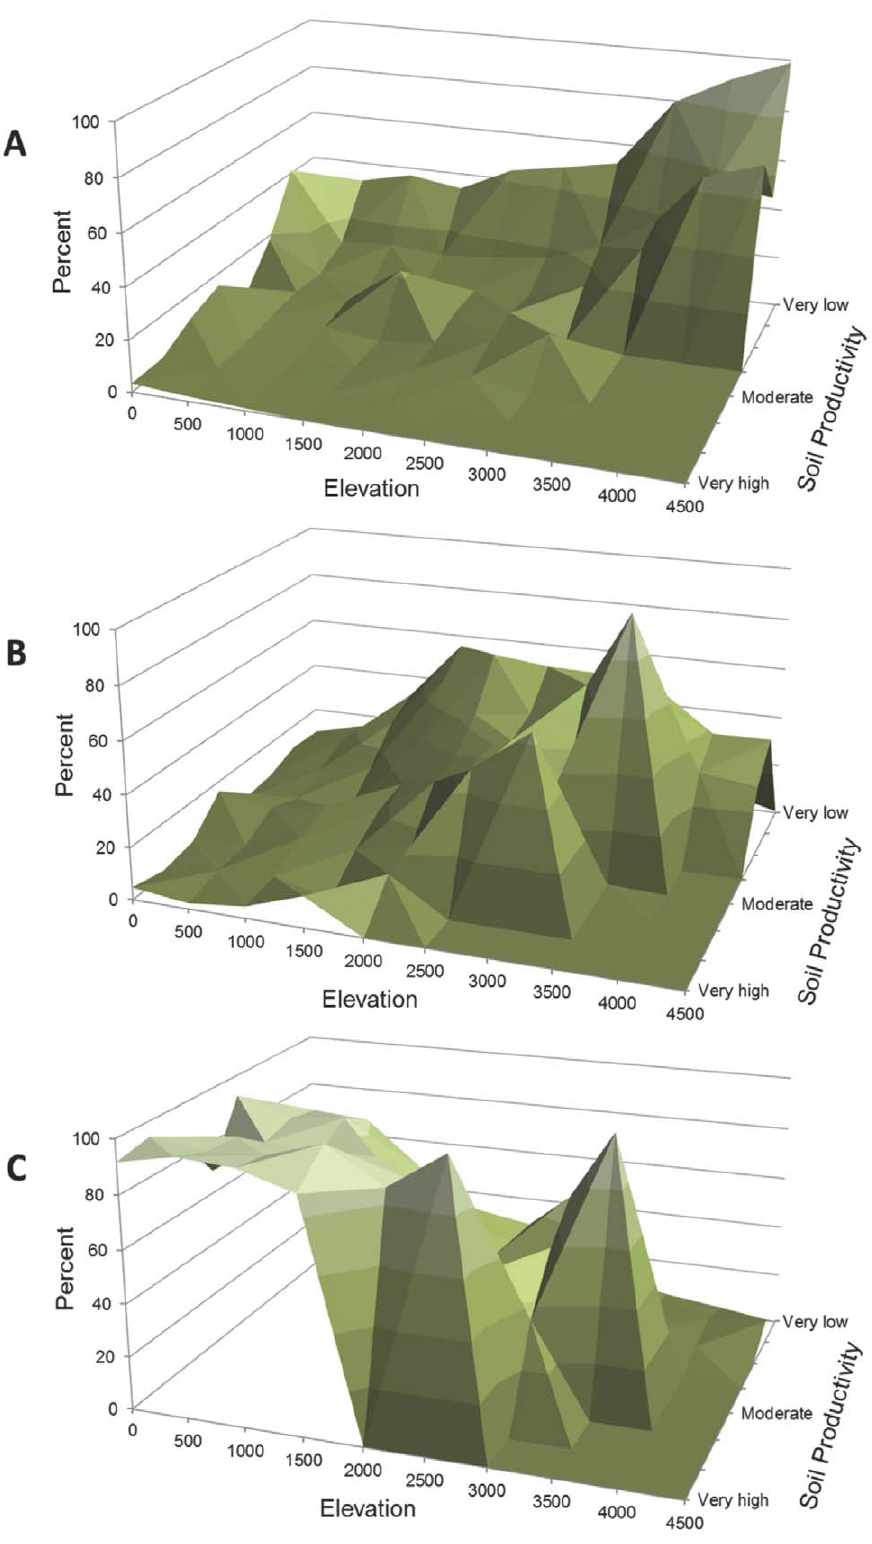
Figure 1. Percent area of ecological systems in relation to elevation, soil productivity, and protection status. Protection status designations include lands managed to maintain biodiversity (A), lands managed for multiple-use (B), and lands that have no permanent protection (C). See Table 1 for protection status descriptions. Percent area of ecological systems determined by combining data for elevation (meters) and soil productivity (http://soils.usda.gov/technical/handbook) with ecological systems grouped by protection status [23,24,60].